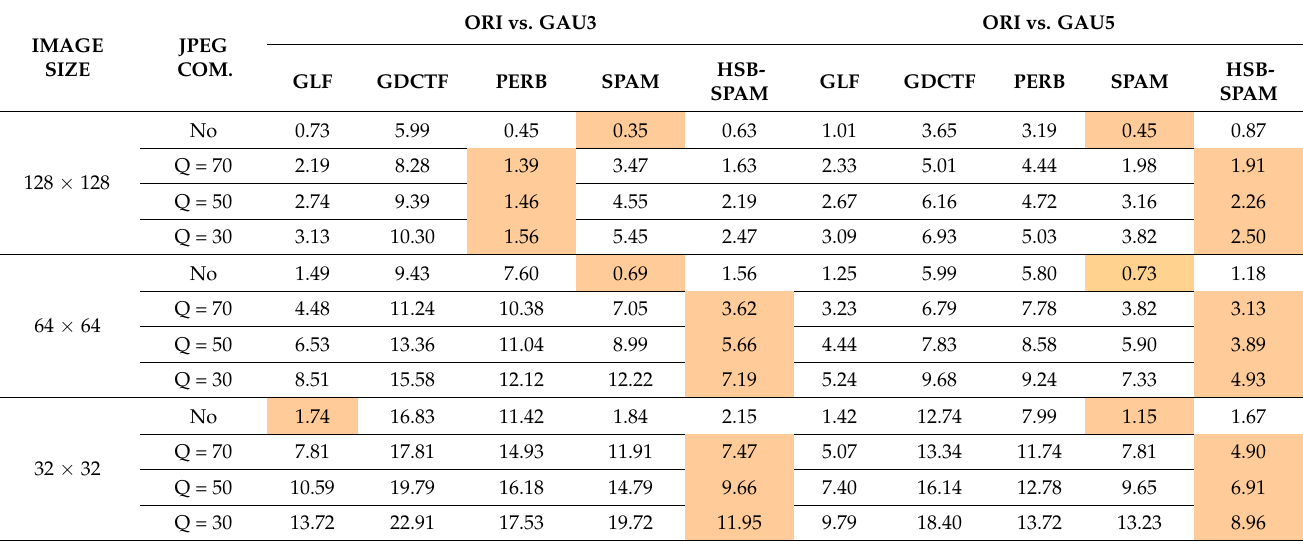
Table 3. Percentage of detection error onGAU3 and GAU5